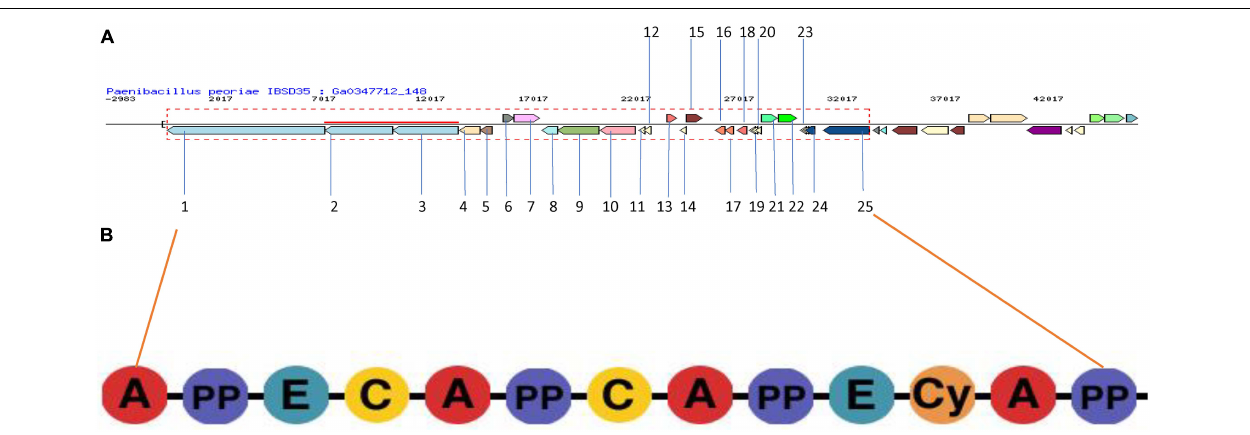
TABLE 4 | The physiochemical properties of Peoriaerin II. Peptide No of aa Aliphatic index Mass PTM GRAVY Molecular formula Instability index (II) Theoretical PI MESEDHISCLPYTNHVSR STTVTSLNSHTYTLTFPTEISQR